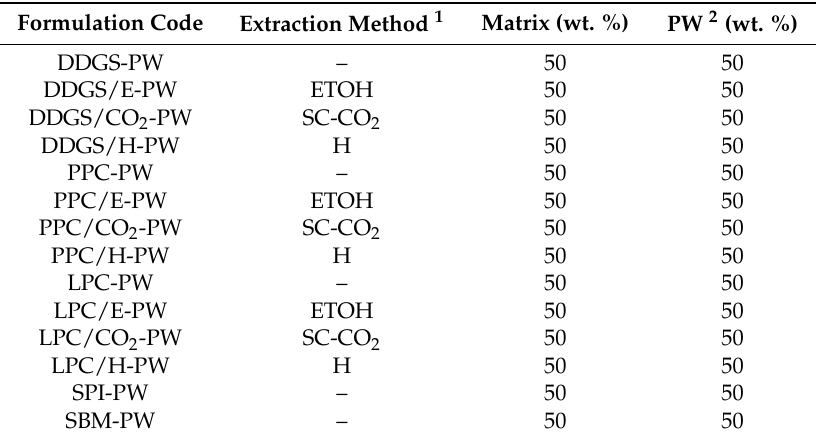
Table 1. Weight percentage (wt. %) of tested composite